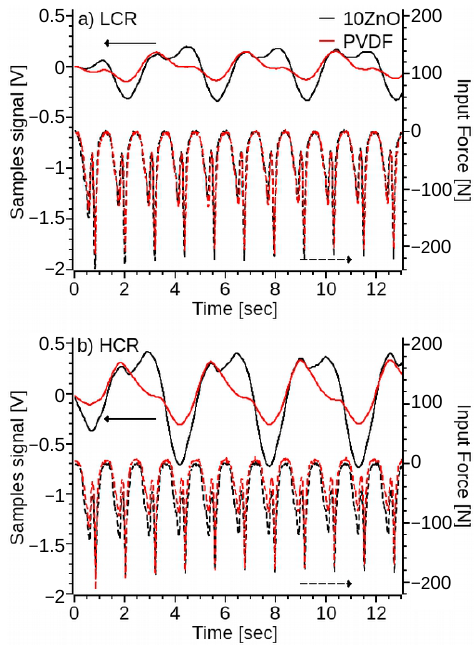
Figure 13. Voltage signal generated in response to a walking profile simulated on an MTS tensile frame for by pristine PVDF and 10%ZnO PVDF nanocomposite samples created with: ( a ) LCR and ( b ) HCR 3D printing